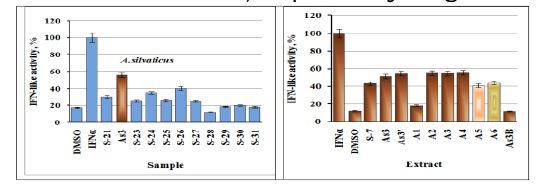
Fig.1. IFN-like activity extracts of Agaricus silvaticus Schaeff ex. Secr